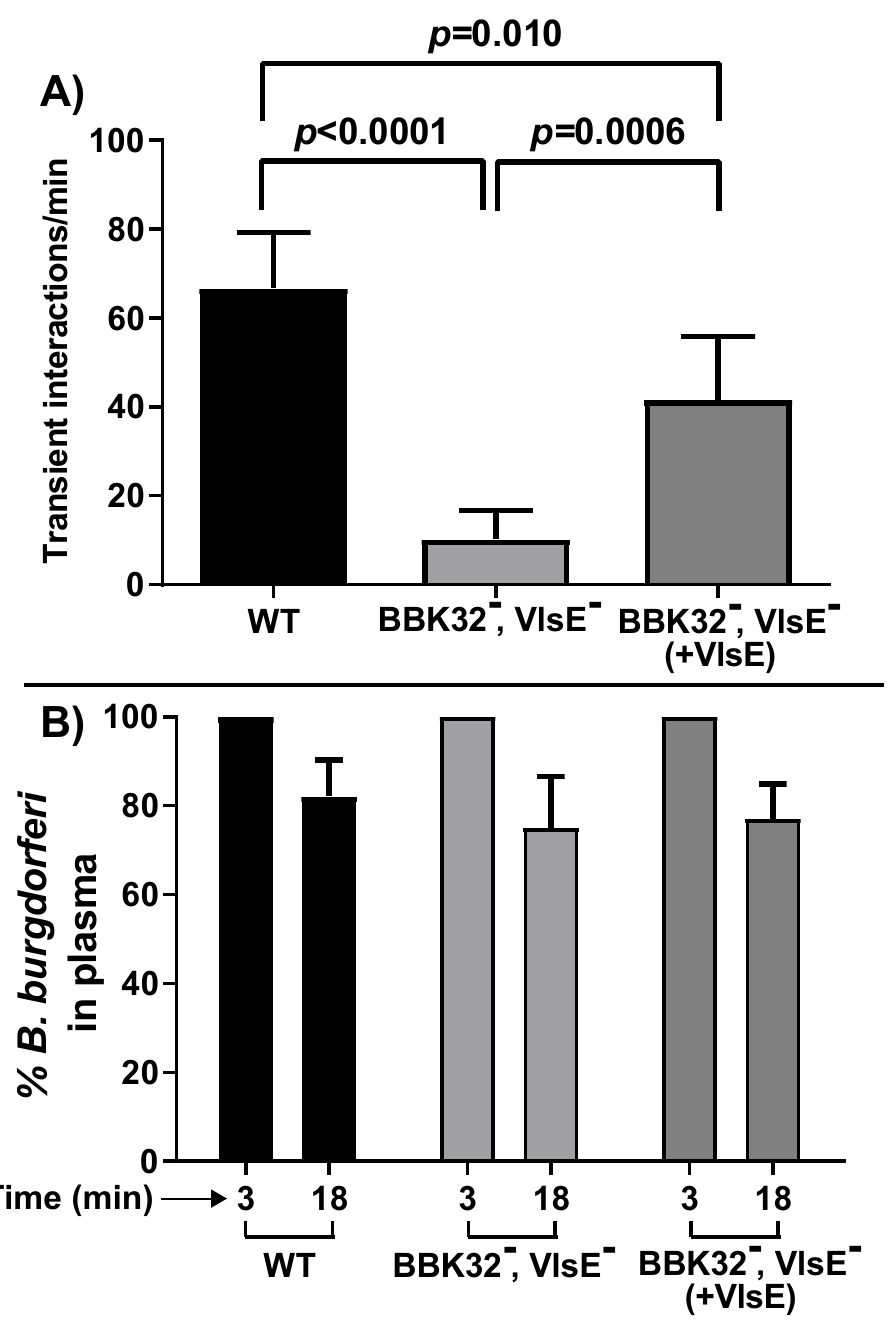
Fig 5. Intravital imaging to investigate microvascular interactions of a low-passage doubly deficient strain lacking VlsE and BBK32, and its VlsE complemented strain. Microvascular interaction rates in knee joint-proximal vessels are shown for three GFP-expressing B . burgdorferi strains, as analyzed by high acquisition rate spinning disk confocal intravital microscopy (see Table 1 for strain info). A) The effect of wild type strain (GCB726), VlsE, BBK32 doubly deficient strain (GCB4036) and the doubly deficient strain complemented with VlsE (GCB4517) on transient microvascular interactions. Error bars represent SD and statistical significance was analyzed using the non-parametric two-stage linear step-up procedure of Benjamini, Krieger and Yekutieli (n = 4 mice). B) Clearance of B . burgdorferi from the blood in the infected mice used in panel A was monitored with the same method as in Fig